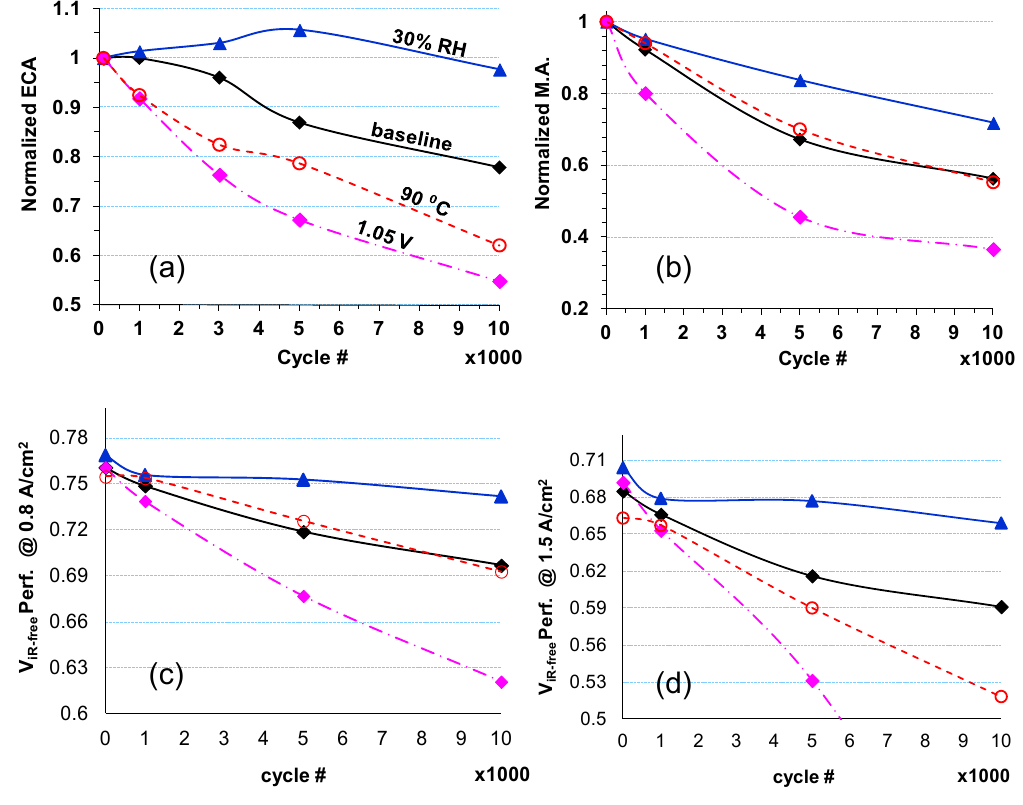
Figure 8. Pt 3 Co cathode catalysts normalized ECA loss ( a ), normalized mass activity (M.A.) loss ( b ) and H 2 /Air performance loss at 0.8 A/cm 2 ( c ) and 1.5 A/cm 2 ( d ) under extreme operating conditions after 0.4–0.95 V square wave cycling (20